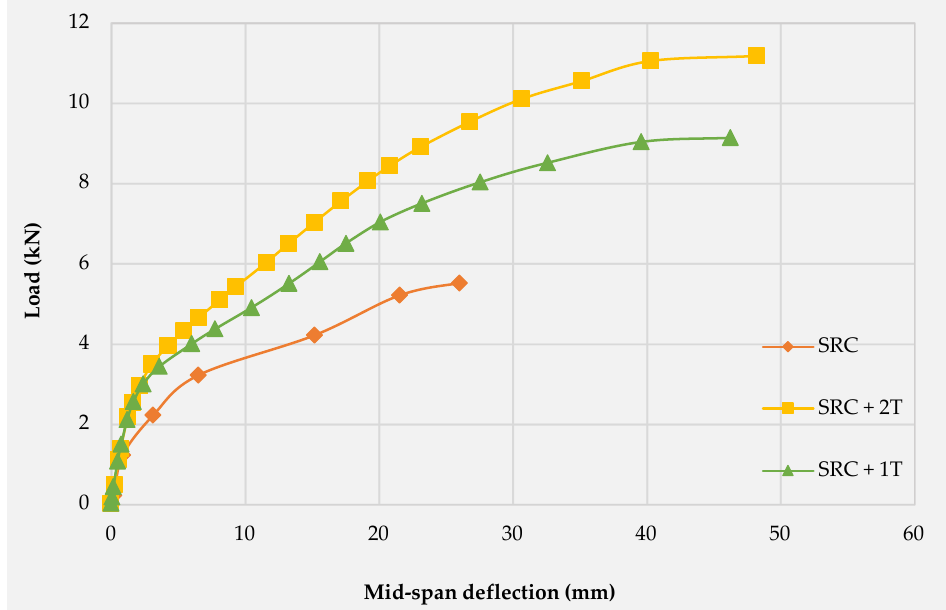
Figure 8. Load versus mid-span deflection curve for the three tested slabs.